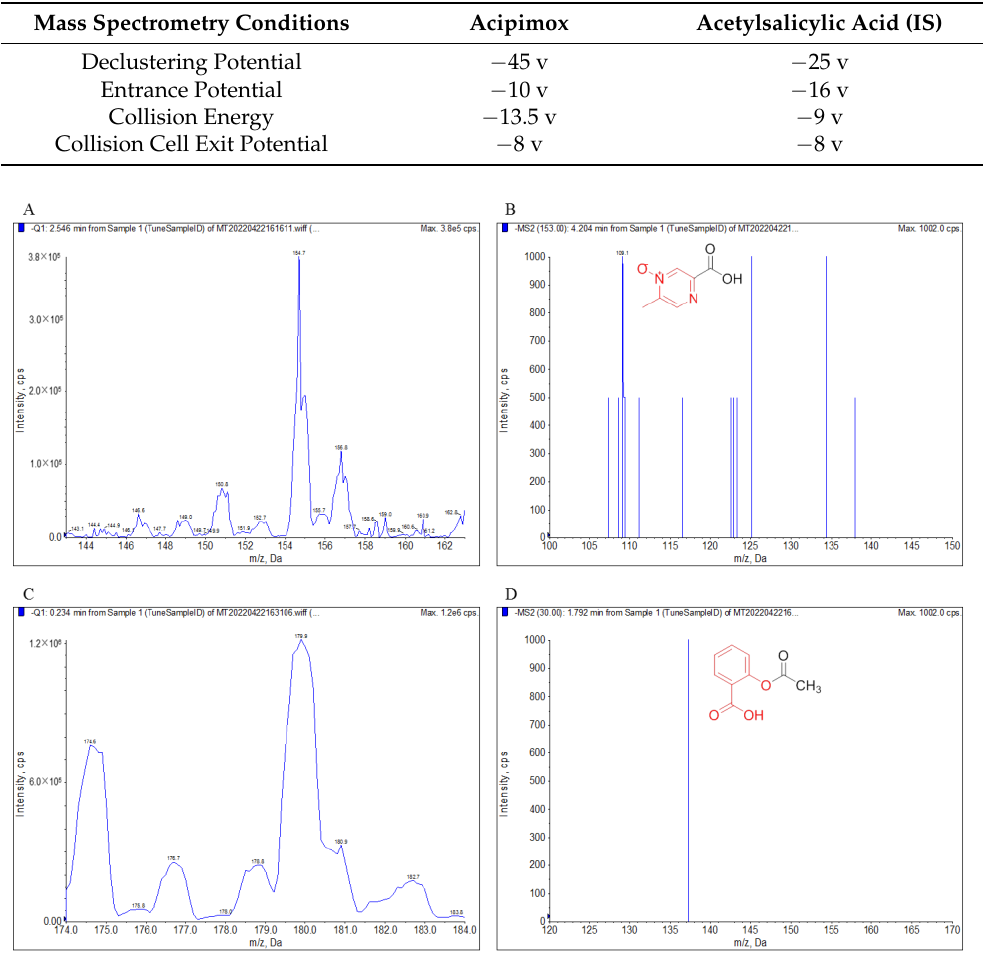
Figure 2. The MS Scan spectra, product ion spectra of [M − H] − and their fragmentation pathways. The MS Scan spectra of acipimox ( A ), product ion spectra of [M − H] − of acipimox ( B ), MS Scan spectra of IS ( C ), and product ion spectra of [M − H] − of IS ( D